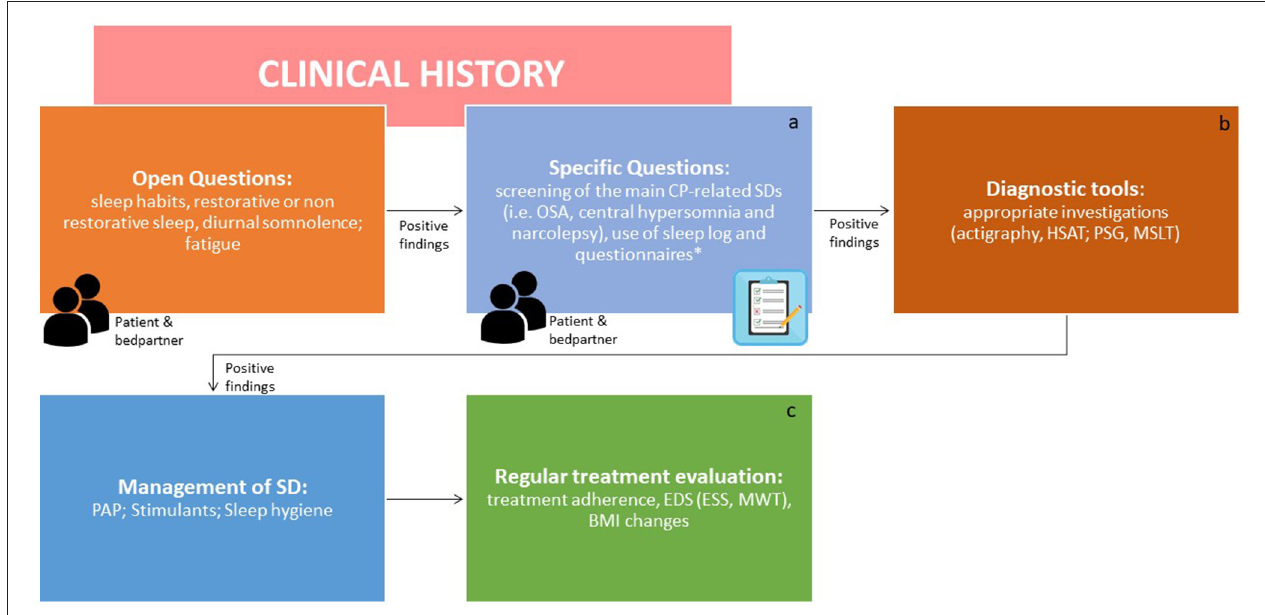
FIGURE 1 | Algorithm for the screening and identification of sleep disorders in patients with craniopharyngiomas. ICSD-3, International classification of sleep disorders version 3; CP, craniopharyngioma; SDs, sleep disorders; OSAS, obstructive sleep apnea syndrome; HSAT, home sleep apnea test; PSG, polysomnography; MSLT, multiple sleep latency test; CRSWD, circadian rhythm sleep-wake disorders. Endocrinologists and neurosurgeons should be involved in the screening step. The second step should be performed by a sleep specialist. a Diaries can help to obtain clinical points in a standardized manner. *The use of formal screening questionnaires for sleep disorders is advisable [i.e., STOP BANG for sleep apnea, Pittsburgh Sleep Questionnaire Index (PSQI) for SDs, Epworth Sleepiness Scale for EDS, Morningness-Eveningness Questionnaire to identify chronotype]. b SDs should be managed as per overall guidelines. c The effects of treatments should